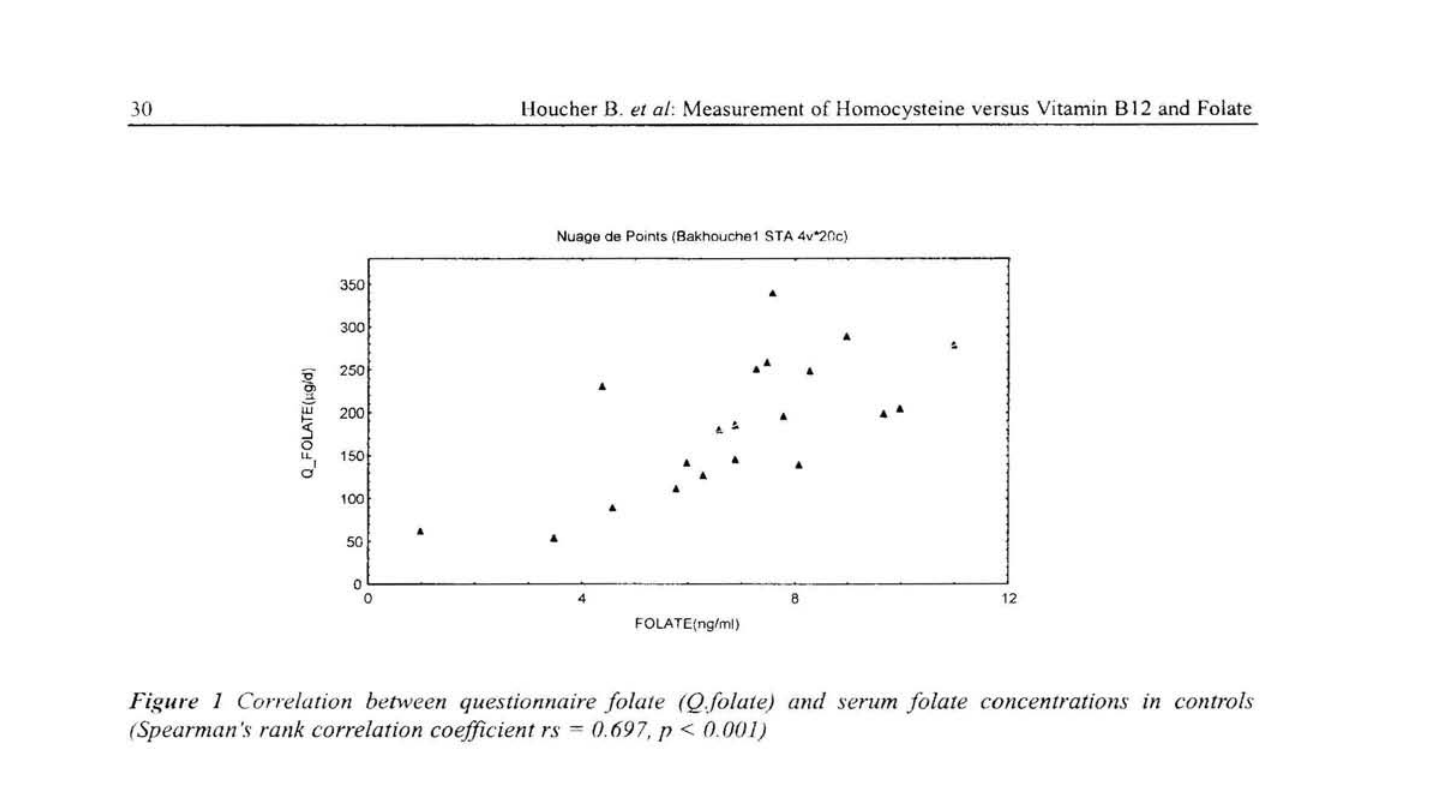
Figure 1 Correlation between questionnaire folate (Q.folale) and serum folate concentrations in controls (Spearman's rank correlation coefficient rs = 0.697, p <